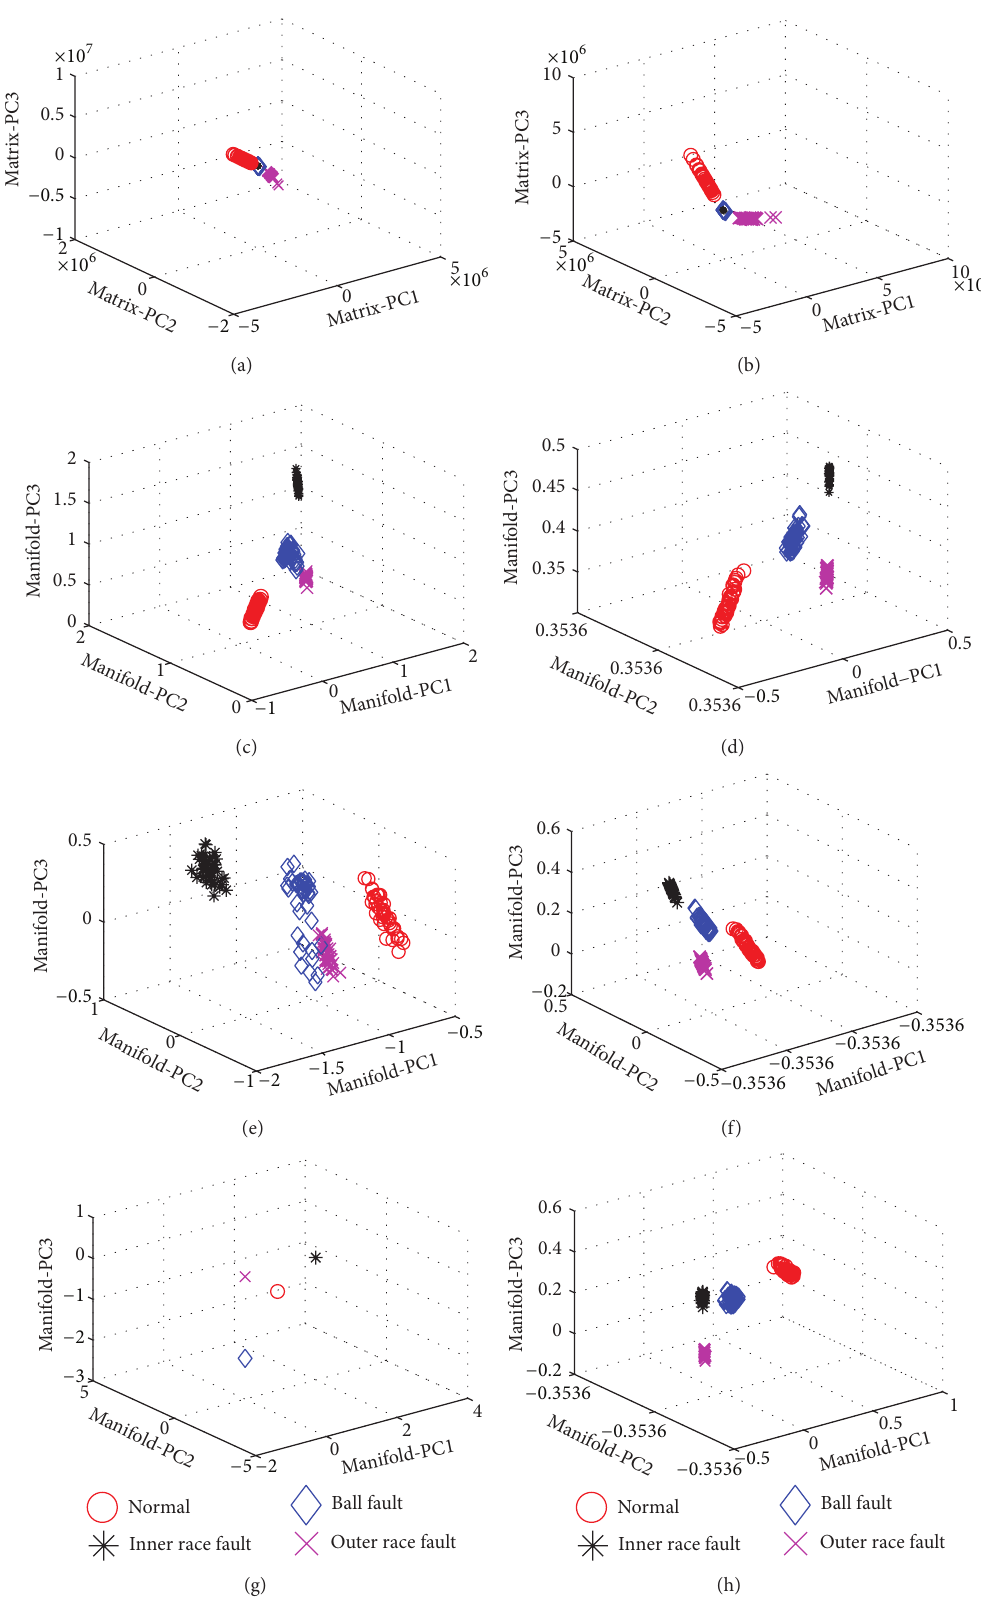
Figure 7: Scatter plots of bearing vibration samples by different features: (a) KPCA Matrix feature of dataset1, (b) KPCA Matrix feature of dataset2, (c) NPP Manifold feature of dataset1, (d) NPP Manifold feature of dataset2, (e) LLD Manifold feature of dataset1, (f) LLD Manifold feature of dataset2, (g) KLLD Manifold feature of dataset1, and (h) KLLD Manifold feature of